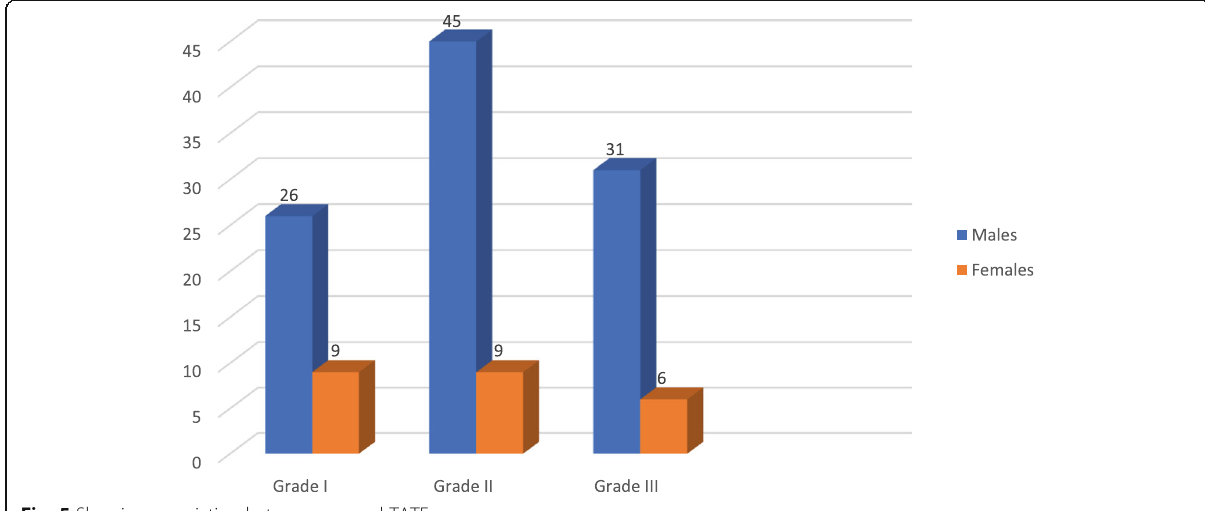
Fig. 5 Showing association between sex and TATE score